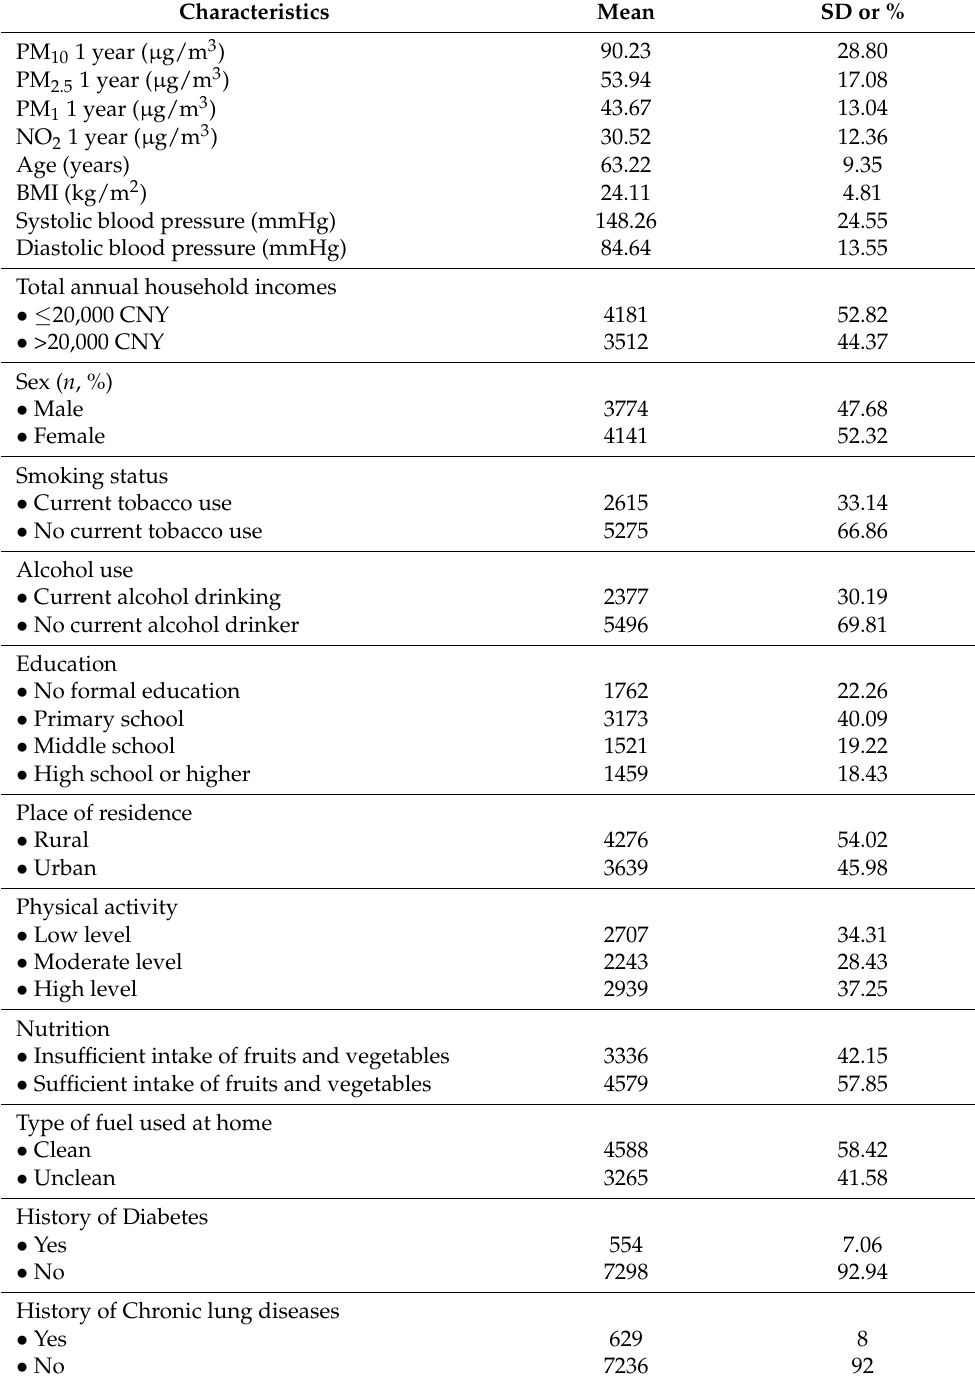
Table 1. Baseline characteristics of study